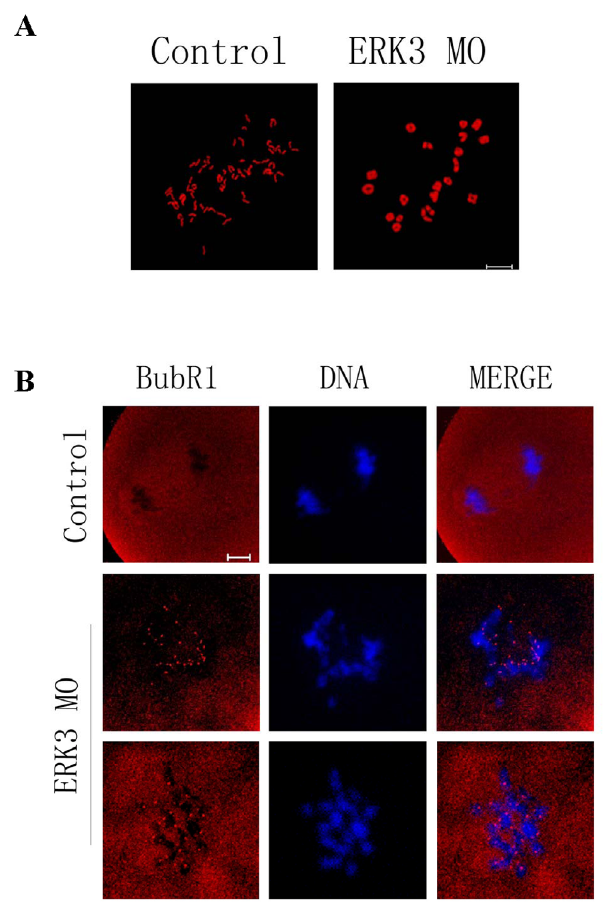
Figure 5. ERK3 deletion inhibited chromosome segregation and activated SAC protein BubR1. (A) Oocytes of control and ERK3 MO groups were cultured for 10 h, followed by chromosome spreading experiments. (B) Detection of BubR1 in oocytes in control and ERK3 MO groups. Red, BubR1; blue, DNA. Bar=10 m m.